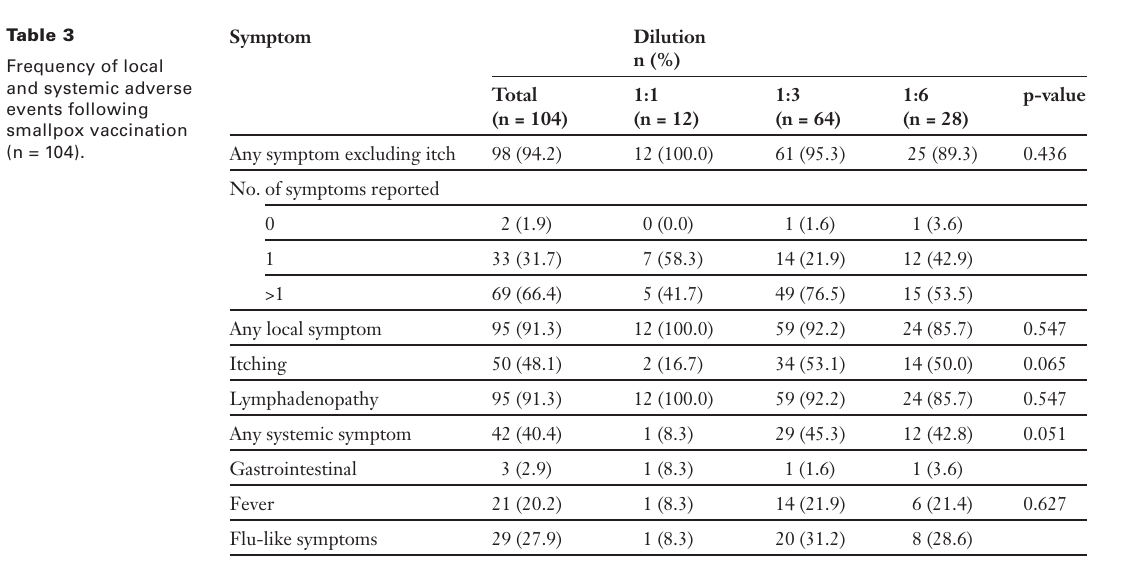
Frequency of local and systemic adverse events following smallpox vaccination (n =